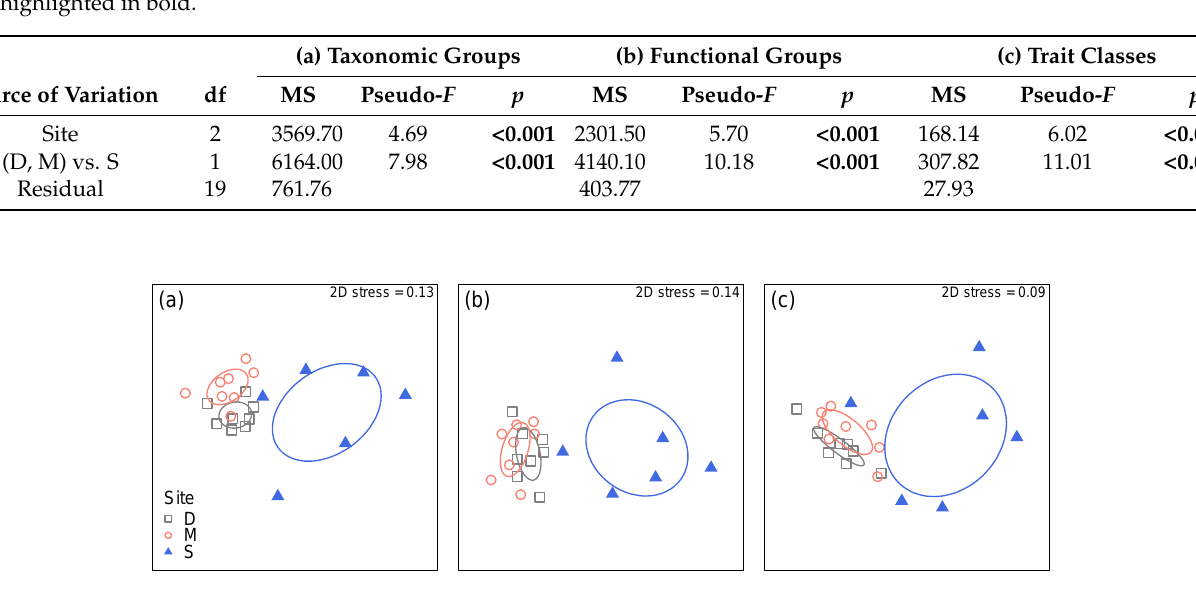
Figure 4. Non-metric multidimensional scaling (MDS) plot of lichen community structure as ( a ) taxonomic and ( b ) functional groups, and ( c ) functional trait composition, using ‘plot-level’ data summarised for each plot. Based on Bray-Curtis dissimilarities calculated from log10(x + 1)-transformed abundance data. Ellipses represent the standard deviation of points within each group.